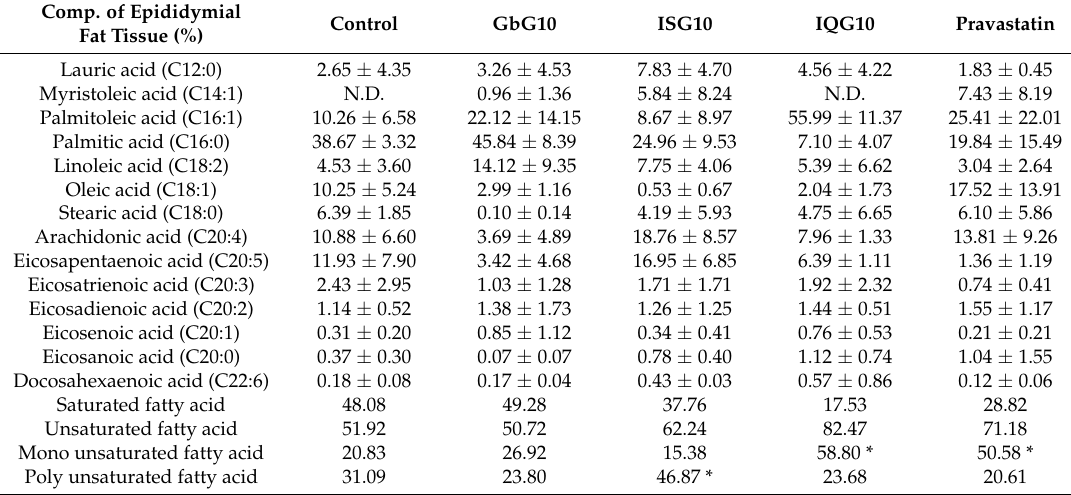
Each value represents mean ± SD. Asterisk marks (*) mean significant differences compared with the control (PBS) group ( p < 0.05). N.D.: not detected.